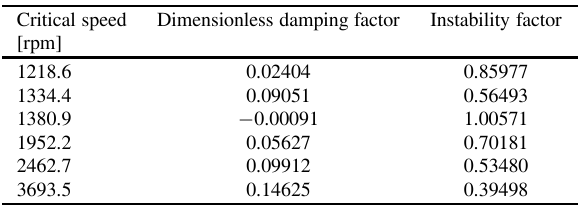
Table 7 Flexural critical speeds and instability factors associated with the fi rst six eigenvalues of the model of the power unit evaluated considering a dimensionless megawatt load equal to 1.65